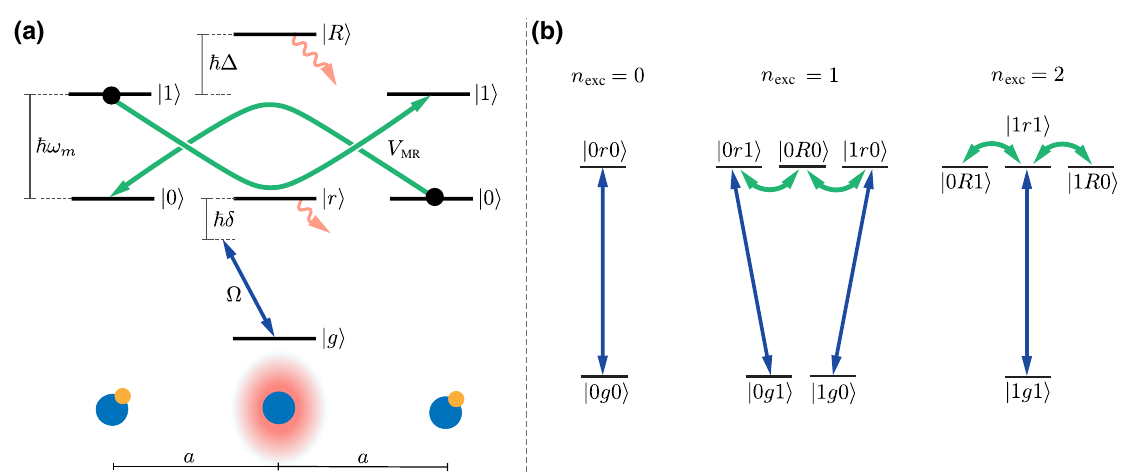
FIG. 1. Relevant level structure for a driven Rydberg-mediated exchange between two molecules. (a) The relevant energy levels for the molecules (left and right) and the Rydberg atom (center). The energy spacing between the computational basis states for the molecule is (cid:2) ω m , and the spacing between Rydberg states | r (cid:2) and | R (cid:2) differs from the molecule spacing by (cid:2) (cid:6) . The excitation laser, which excites an atom from | g (cid:2) to | r (cid:2) , has Rabi frequency (cid:7) , and its detuning is denoted by (cid:2) δ . (b) The separation of the three-body Hilbert space (12 states) into distinct subspaces. The blue lines indicate the Rydberg excitation laser coupling, and the green lines depict the strong Rydberg-molecule